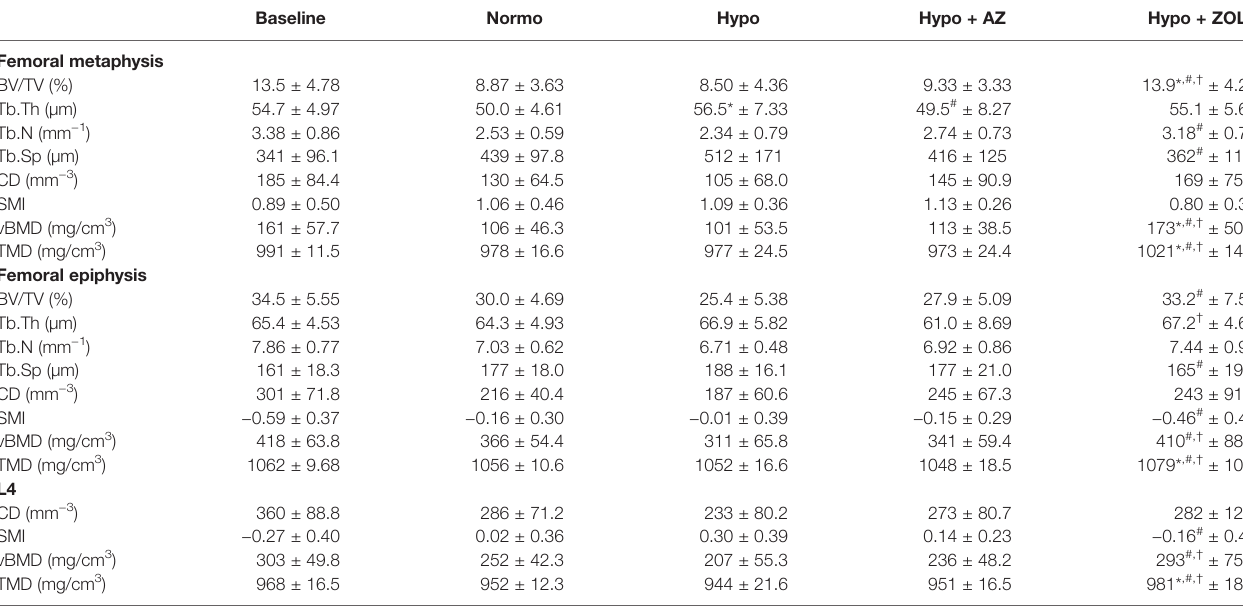
TABLE 3 | Microstructural properties of the distal femoral metaphysis and epiphysis and L4 of mice housed at normobaric ambient pressure (Normo) or hypobaric pressure (Hypo) at 500 mbar for four weeks and treated with acetazolamide (AZ) or zoledronate (ZOL). Baseline